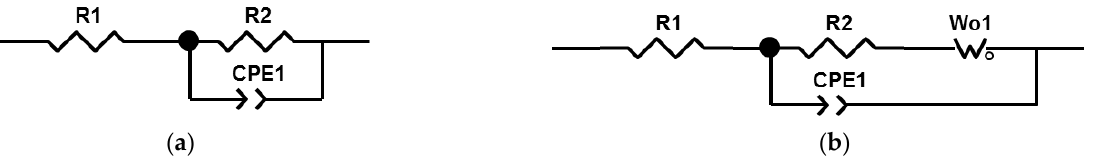
Figure 7. Equivalent circuits used for the electrochemical impedance spectroscopy (EIS) results fitting: ( a ) uncoated Ti and TZN substrates; ( b ) Ti+PEO and TZN+PEO coated samples.